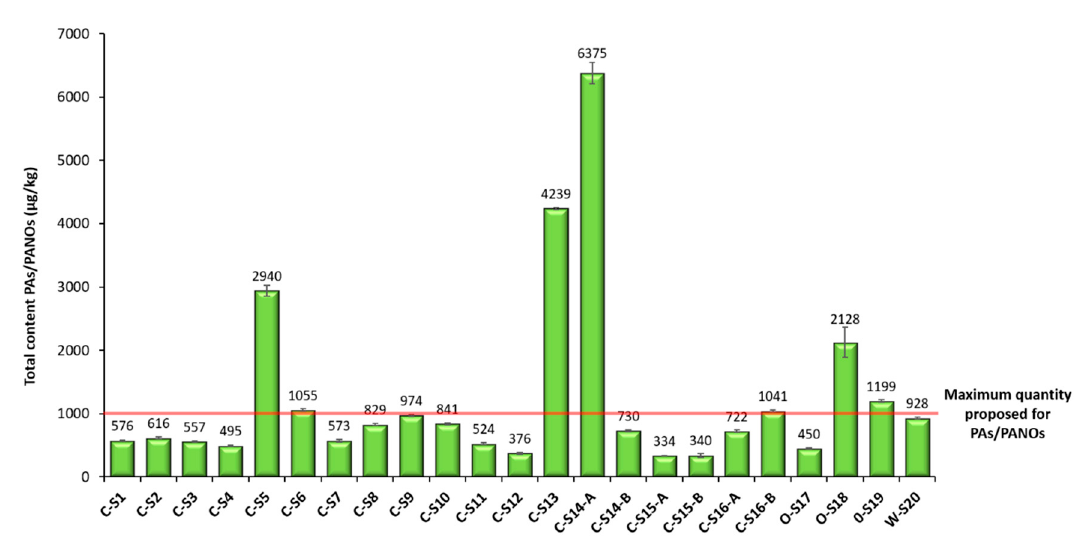
Figure 4. Total content of PAs/PANOs (µg/kg) found in the different oregano samples analyzed by the µ-QuEChERS method proposed. In the sample identification code, the first letter indicates: W for wild farming, O for organic farming and C for conventional farming. Samples ending with an A or B indicate same trademark samples with different lot number.